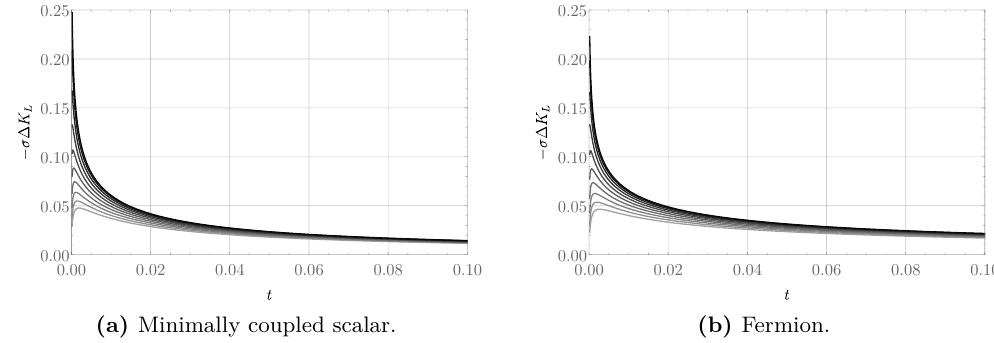
Figure 11. The behavior of ∆ K L at small t for ‘ = 2 and (cid:15) < 0 for the minimally coupled scalar (left) and the Dirac fermion (right). From lightest to darkest, the curves correspond to (cid:15)/(cid:15) min = 0 . 9 to 0 . 99 in intervals of 0 . 01 .